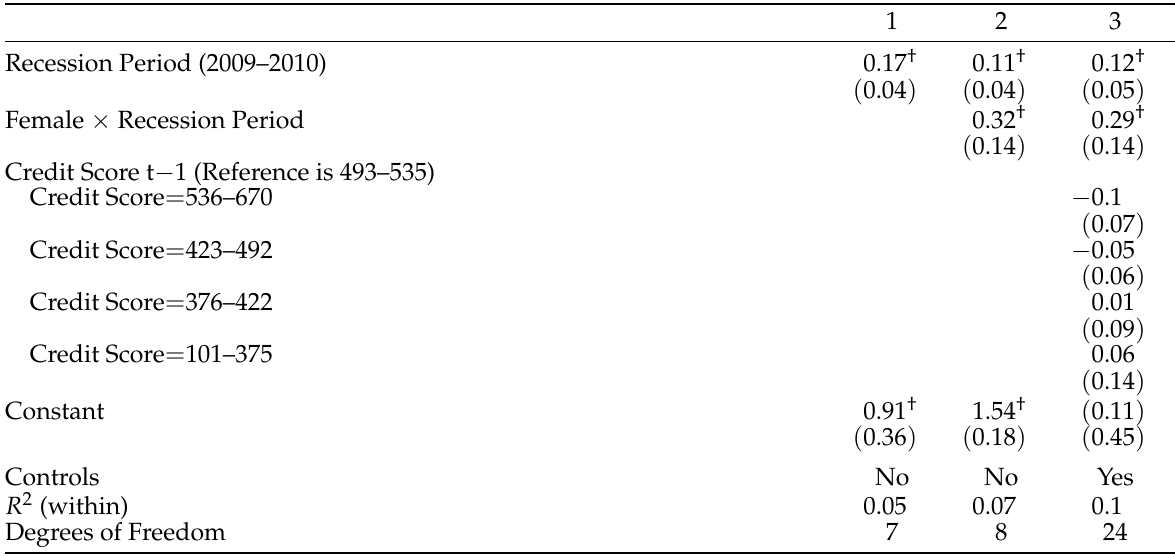
Table 4: Estimated Coefficients From Fixed Effects Ordinary Least Squares Regression Models Predicting